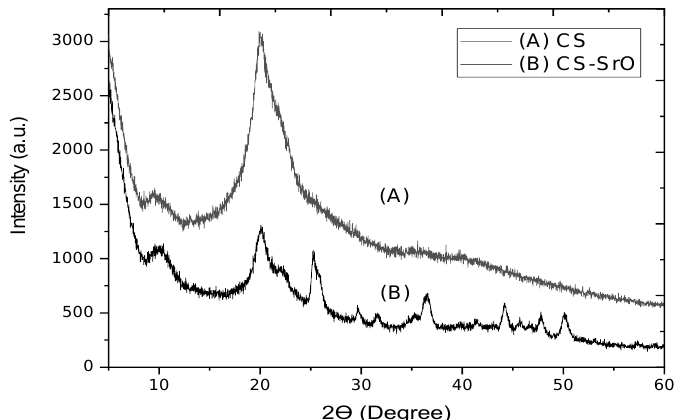
Figure 5. XRD images of chitosan (A) and chitosan-SrO nanocomposite, (10 wt.%) (B).